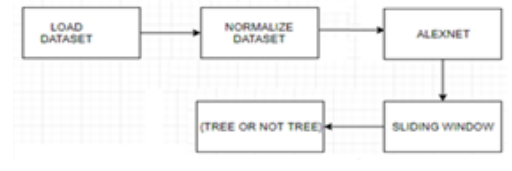
Figure 5 Flowchart of the